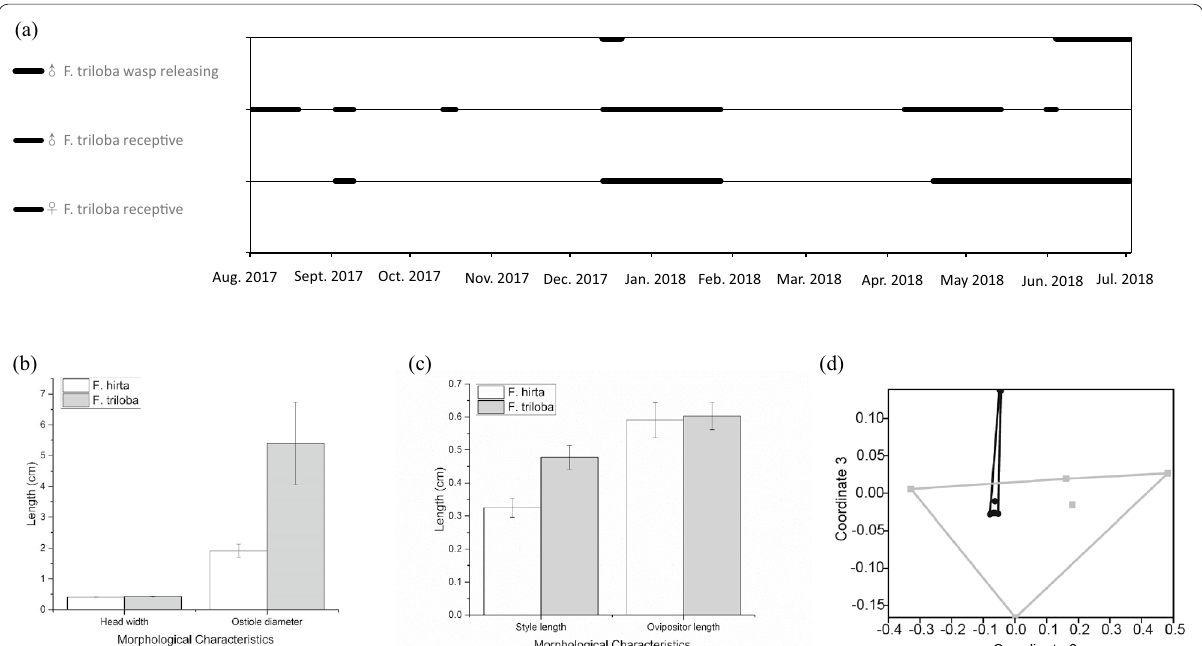
Fig. 3 a The reproductive phenology of nine male and eight female F. triloba at Dinghu Mountain. Each thick bar shows a particular developmental stage present on at least one of the plants. Emerging (D phase sensu Galil and Eisikowitch 1968) phase male figs release pollinator fig wasps, which enter receptive (B) phase male and female figs where they pollinate and attempt oviposition. In contrast to F. triloba , fig production on each male and female F. hirta individual is asynchronous and small numbers of receptive figs and male figs that are releasing pollinators were present almost throughout the year at this site. b Comparison of ostiole diameter in male receptive syconia between F. hirta and F. triloba , and head width between their specific pollinating wasps. c Comparison of style length in male receptive syconia between F. hirta and F. triloba , and ovipositor length between their specific pollinating wasps. d Non-metric multidimensional scaling of receptive floral volatiles of F. hirta (black circles) and F. triloba (grey squares) based on Bray–Curtis dissimilarity index (stress 0.128). =